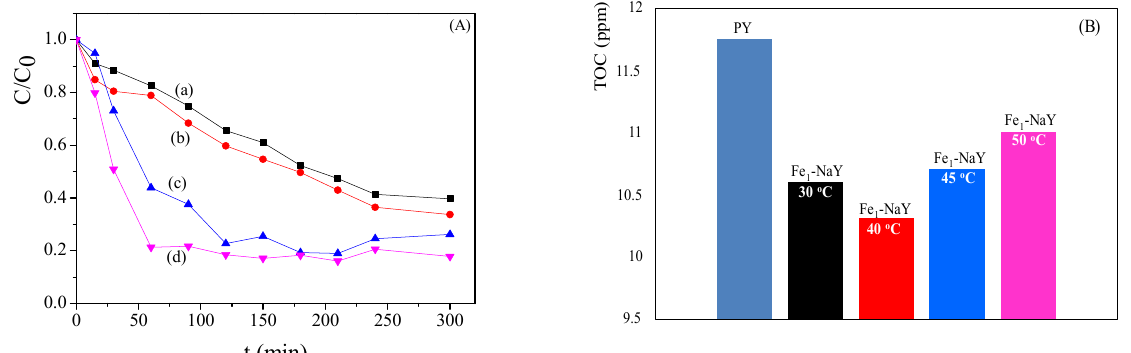
Figure 4. ( A ) Relative PY concentration, C/C 0 , as a function of time for the Fe 1 -NaY catalyst: (a) 30 °C, (b) 40 °C, (c) 45 °C and (d) 50 °C. Other reaction conditions: 50 mg of catalyst, V PY = 250 mL, C 0 = 30 ppm, initial pH = 3.00, C H 2O ( B ) TOC values determined at the end of reaction.